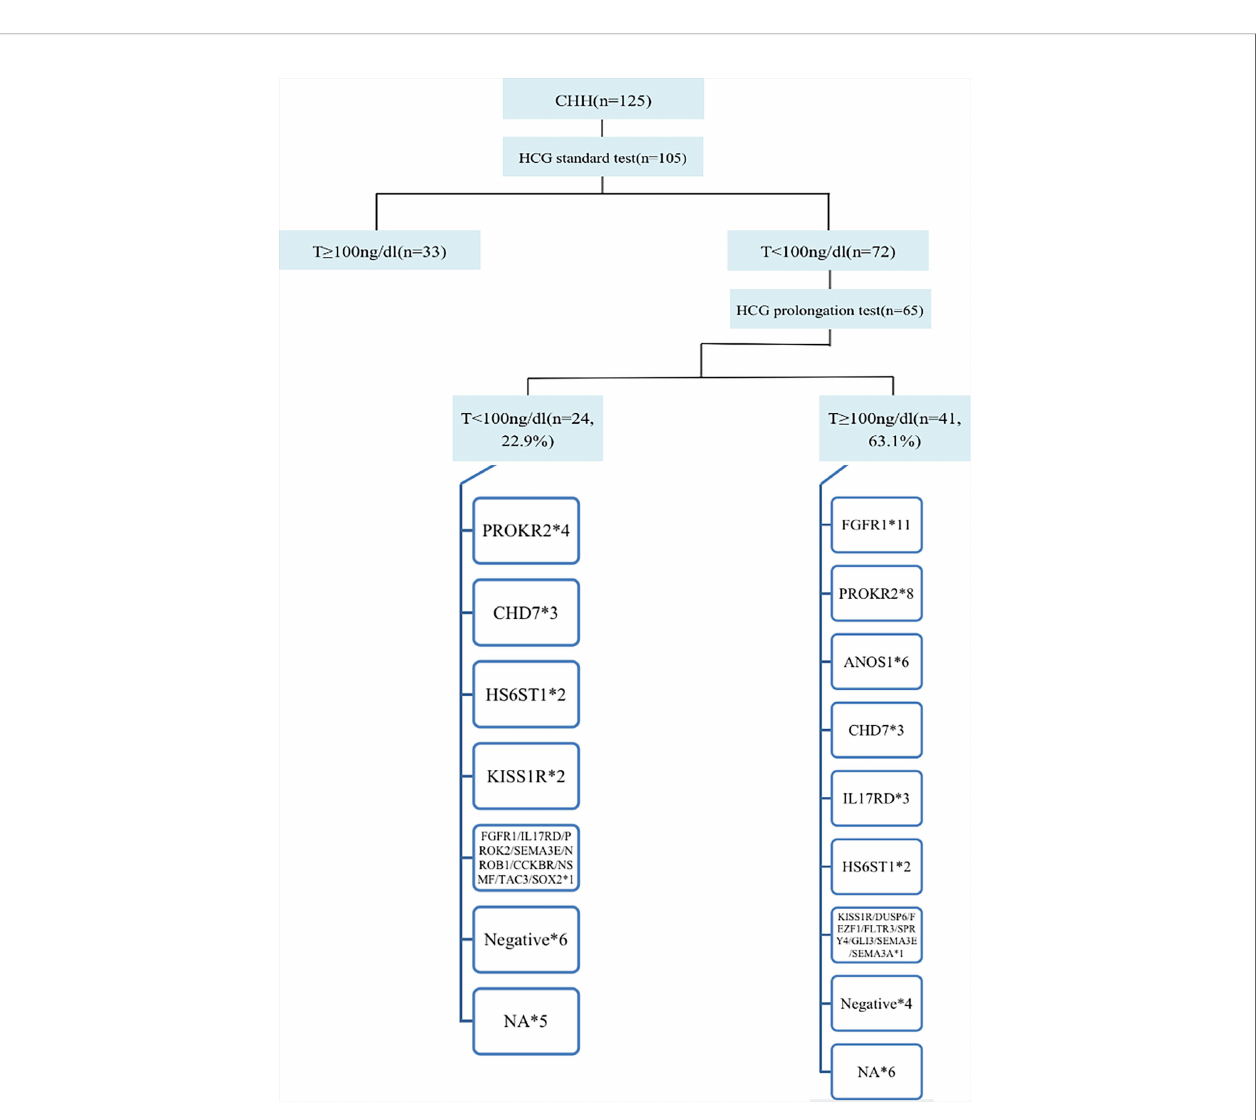
FIGURE 4 | Diagnosis process and gene distribution of dual CHH. 65 patients continued to perform the hCG prolongation test, and T levels of 22.9% (24/105) patients were lower than 100ng/dl, suggesting that these patients also had testicular Leydig cell dysfunction (Dual CHH). In patients with dual and pure CHH, ratio of FGFR1 mutation was 5.3% (1/19) vs. 31.4% (11/35), and there was no signi fi cant difference between the two groups (P = 0.138). *represents the number of cases with the same gene